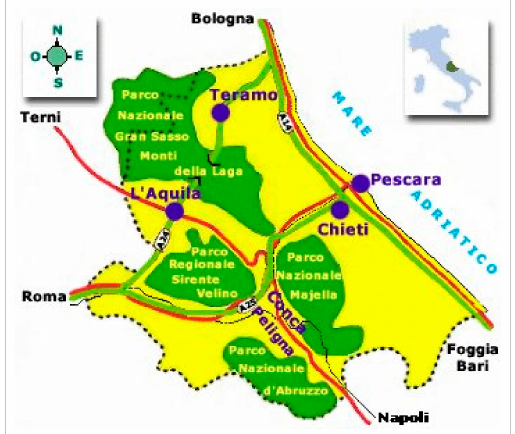
Figure 7. Subdivision by fauna.